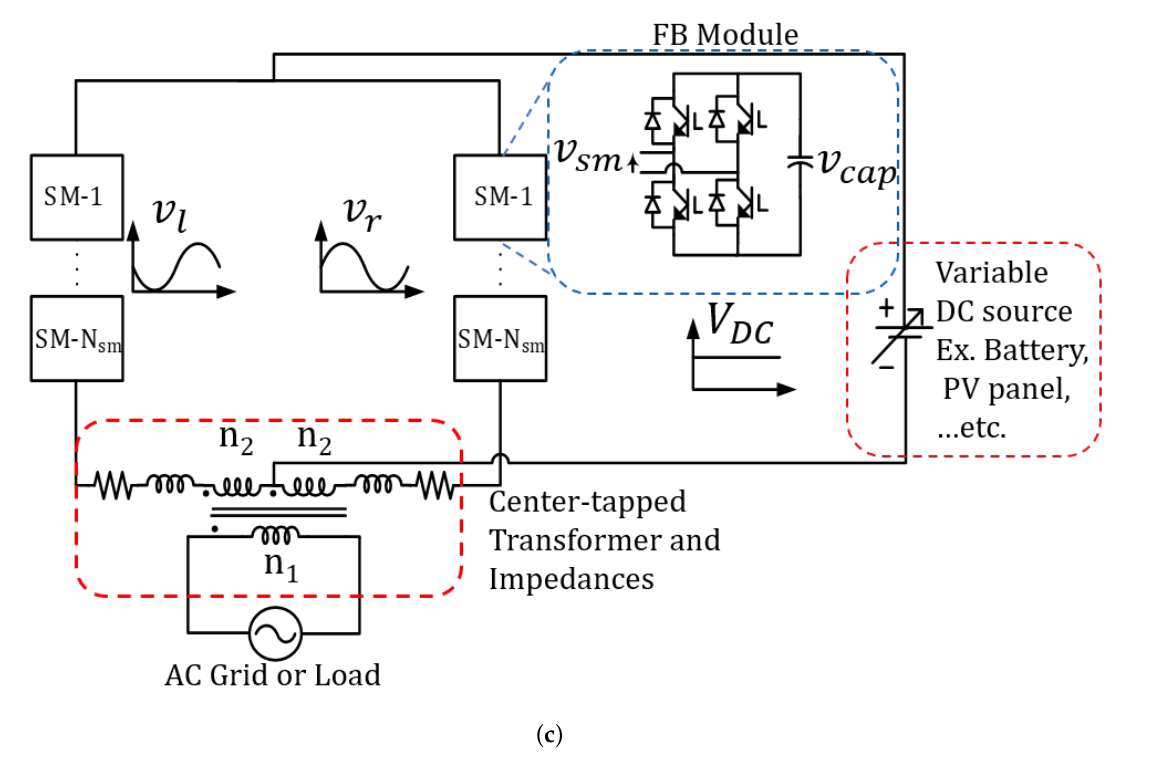
Figure 1. A generalized representation of the conventional topology ( a ), proposed single-stage topology ( b ), and circuit schematic of proposed topology ( c